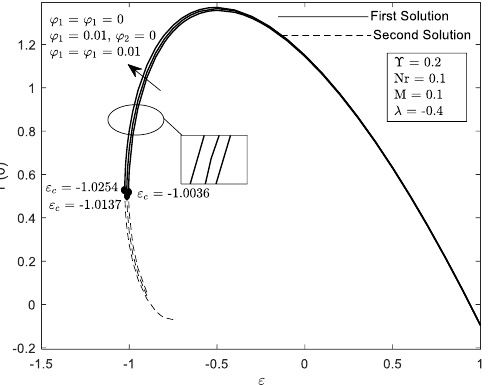
Figure 2. Variation of f (cid:48)(cid:48) ( 0 ) with velocity parameter, ε for types of fluid. Figure 2. Variation of 𝑓 ′′ (0) with velocity parameter, 𝜀 for types of fluid. Figure 2. Variation of 𝑓 ′′ (0) with velocity parameter, 𝜀 for types of fluid. Figure 2. Variation of 𝑓 ′′ (0) with velocity parameter, 𝜀 for types of fluid.